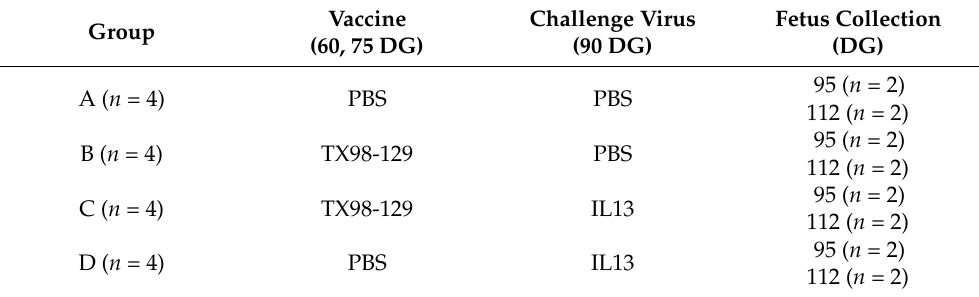
Table 1. Design of pig experiment to assess vaccine efficacy in pregnant sows.